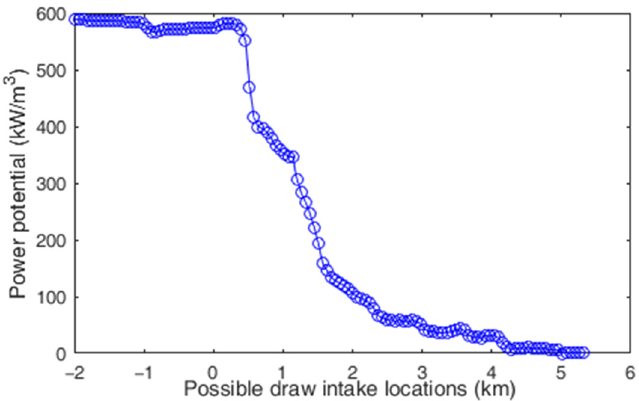
Figure 4. Power production dependence with the location of the draw water for a given feed location at 1.8 km.